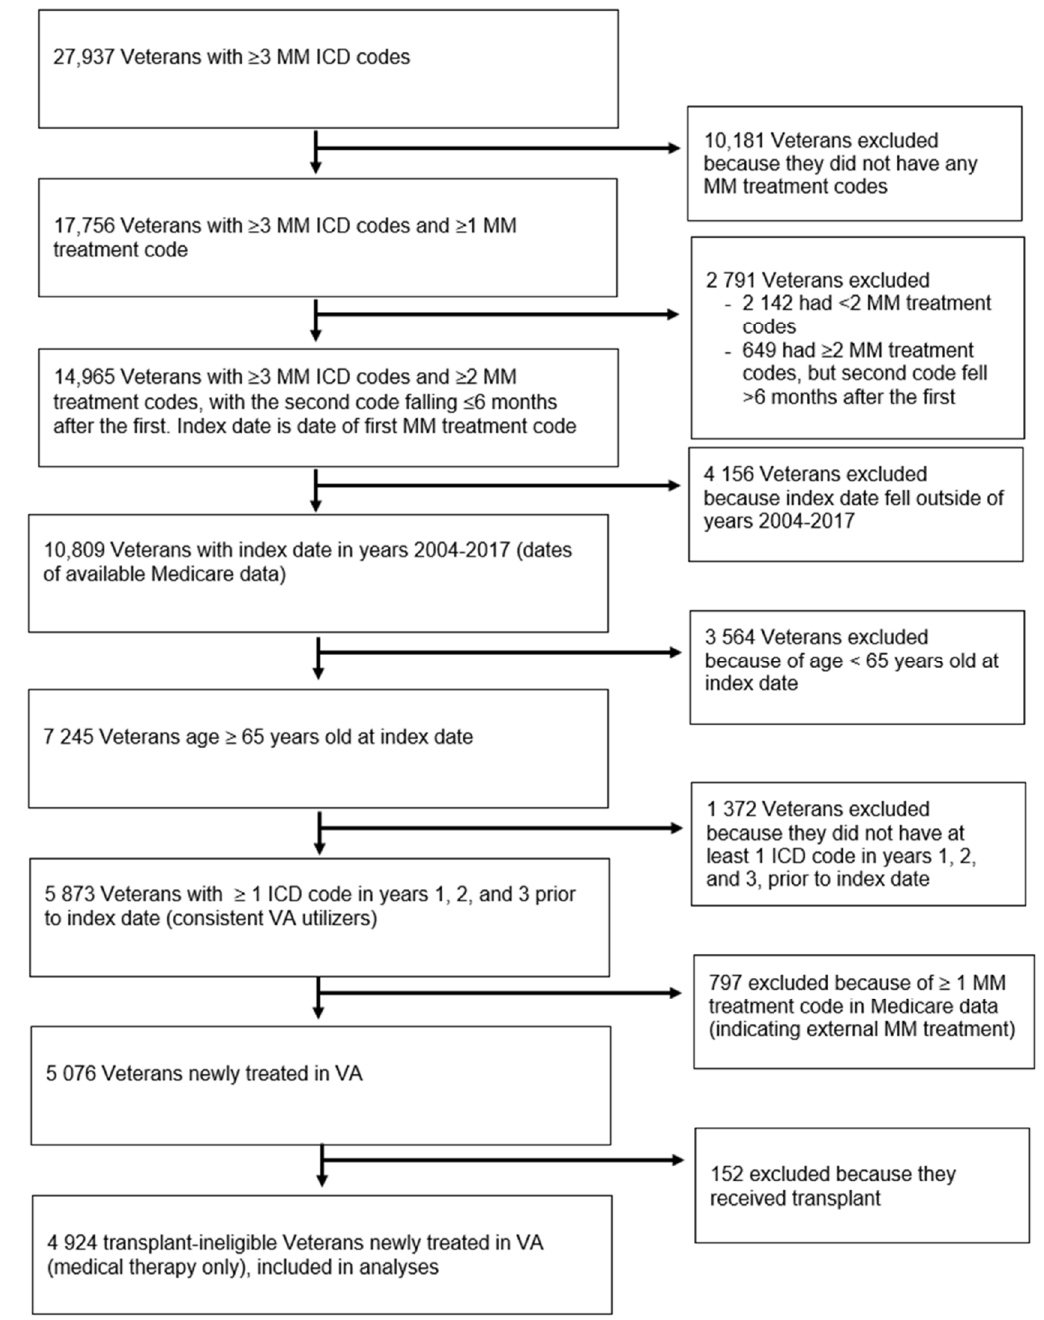
Figure 1. Flow diagram showing identification of the study population of veterans aged ≥ 65 years old with multiple myeloma newly treated in Veterans Affairs. Abbreviations: ICD, International Classification of Diseases; MM, multiple myeloma; VA, Veterans Affairs.